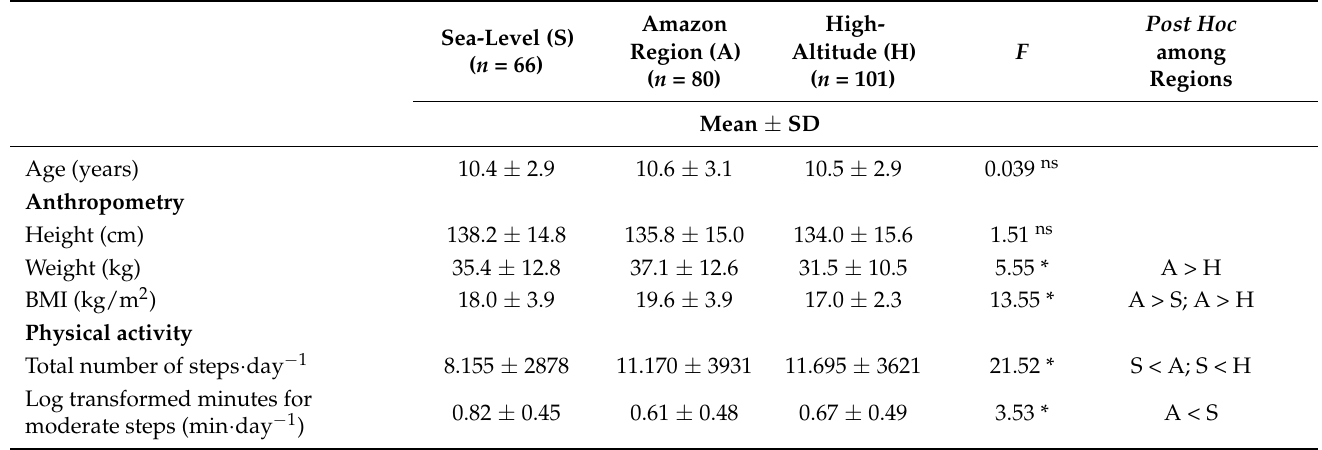
Table 1. Descriptive statistics [means and standard deviations (SD)], F tests and post-hoc comparisons by each geographical